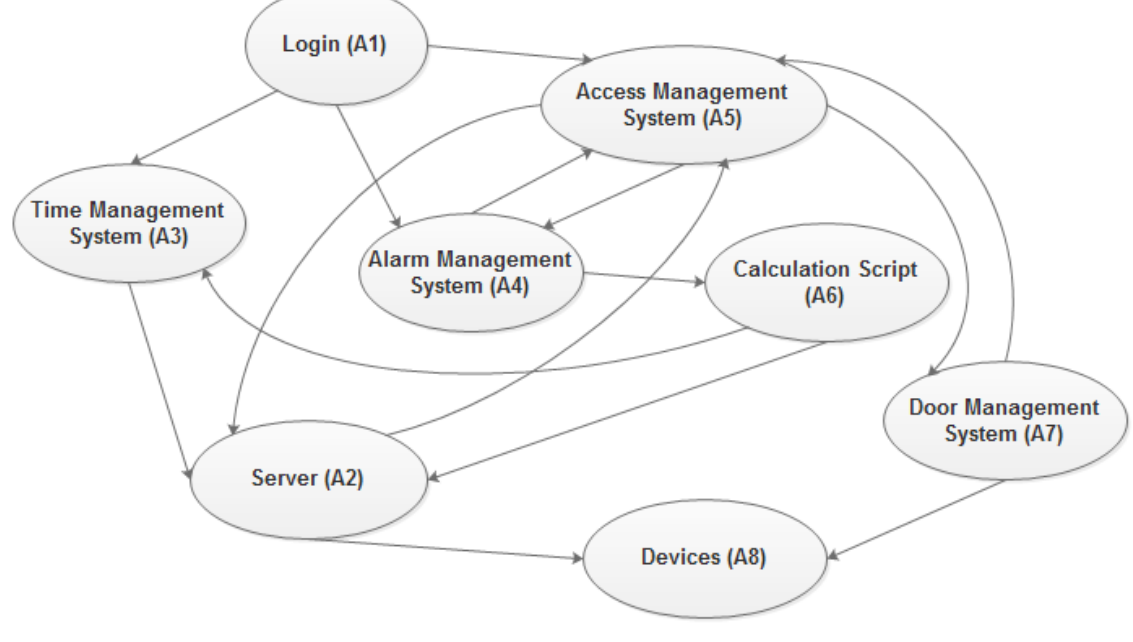
Fig. 2. Graphical representation of